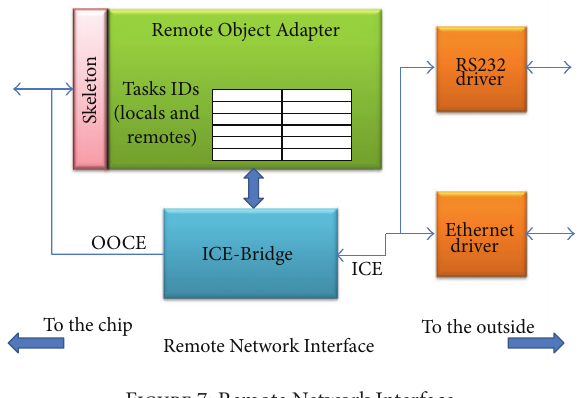
Figure 7: Remote Network Interface.